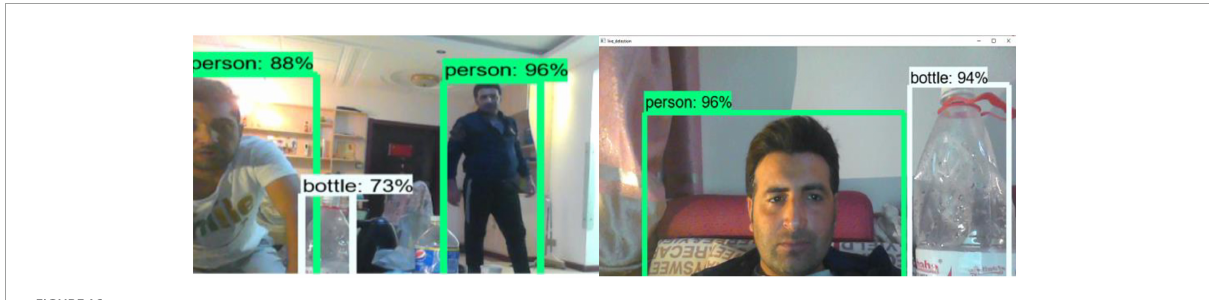
FIGURE16 Live objects detection and recognition and accuracy